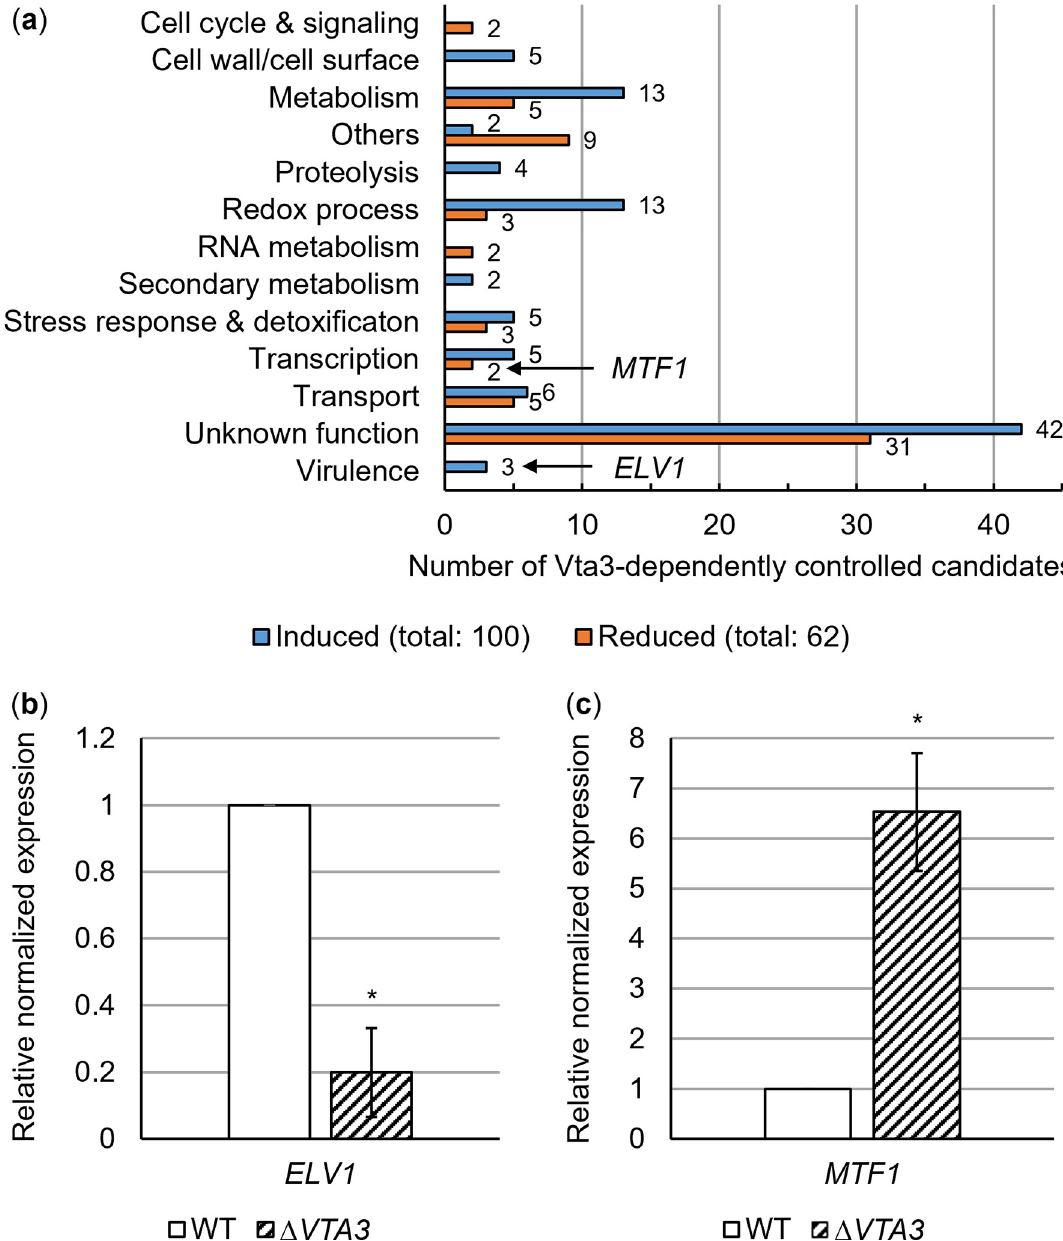
Fig 1. The Verticillium dahliae transcription factor Vta3 affects the expression of 162 fungal genes in tomato xylem sap including the Egh16-like virulence factor-encoding gene ELV1 and the Master transcription factor-encoding gene MTF1 . Equal numbers of spores of V . dahliae JR2 wild-type (WT) or VTA3 deletion strain ( Δ VTA3 ) were used to inoculate liquid simulated xylem medium and incubated for five days with shaking. The mycelia were then transferred to extracted tomato xylem sap and incubated for a further 8 h. (a) The transcriptomes of three biological replicates per fungal strain were analyzed by RNA sequencing. After applying a log 2 (fold change) of � 2, transcript levels of 100 genes were significantly higher in the presence of VTA3 (induced; in blue), whereas expression of 62 genes was reduced (in orange). The products of the differentially expressed genes are involved in various processes including metabolism, redox processes, stress response, transcription, transport, virulence and unknown functions. Putative functions were assigned based on conserved domains identified by searches with InterPro and BLAST. Details are given in S7 Table (Vta3-dependently induced candidates) and S8 Table (Vta3-dependently reduced candidates). (b, c) ELV1 and MTF1 expression levels were analyzed by reverse transcription-quantitative PCR. The transcript levels of references H2A and EIF2B were used for normalization and gene expression levels in wild-type were set to one. Mean values ± SE of the mean from three independent experiments are shown. Significance was calculated using t -tests. (b) The presence of VTA3 leads to a five-fold induction of ELV1 expression ( � , P < 0.05). (c) MTF1 expression was reduced six-fold ( � , P < 0.05) in the presence of VTA3 .